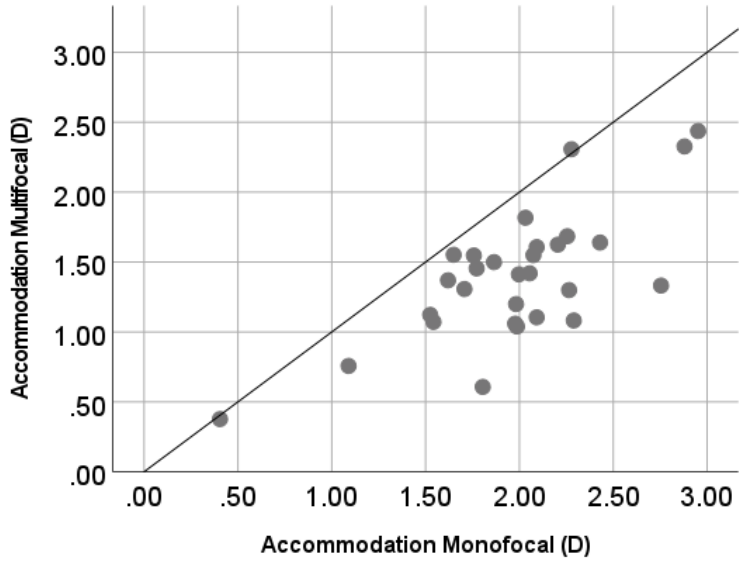
Figure 4. Change of pupil size with accommodation.